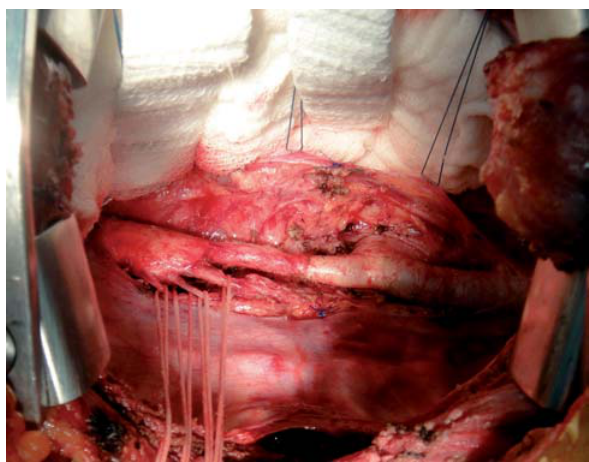
Fig. 3 – Segmento de aorta comprometido após ampla dissecção.